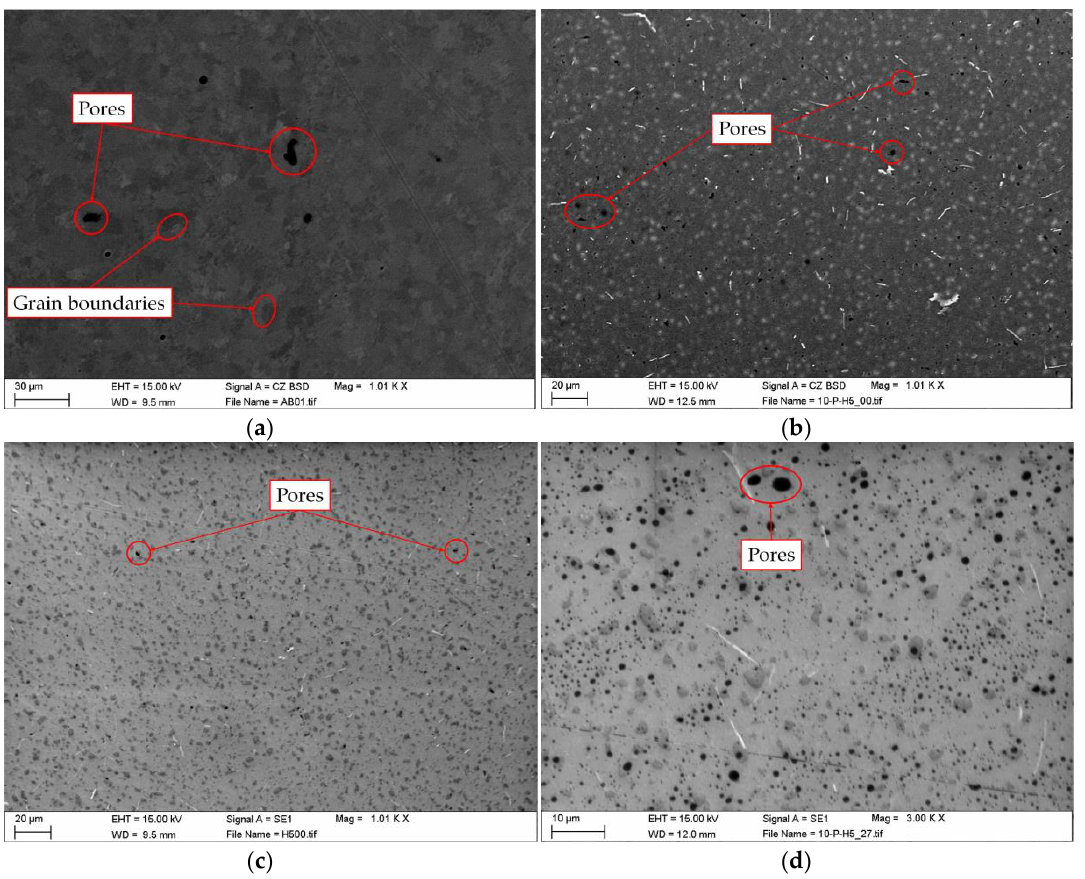
Figure 3. Microstructure ( a ) before and ( b – d ) after post-treatment.